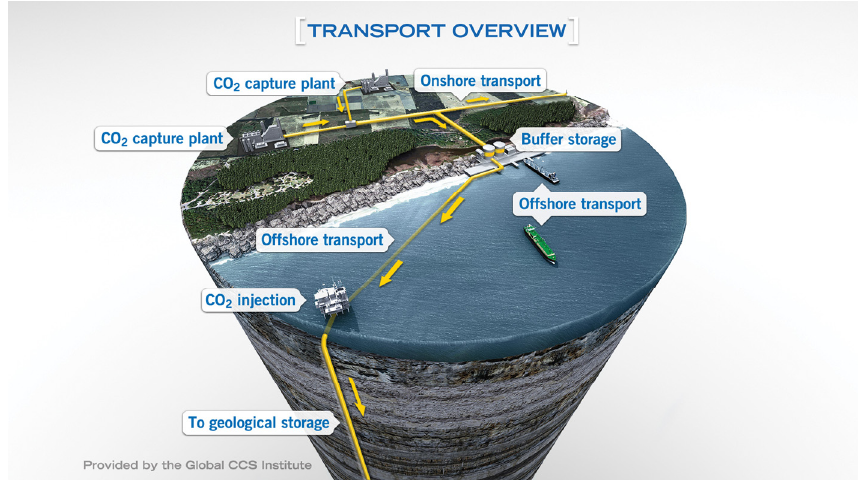
Figure 1. Transportation system in CCS (Source: Provided by Global CCS Institute [8]).